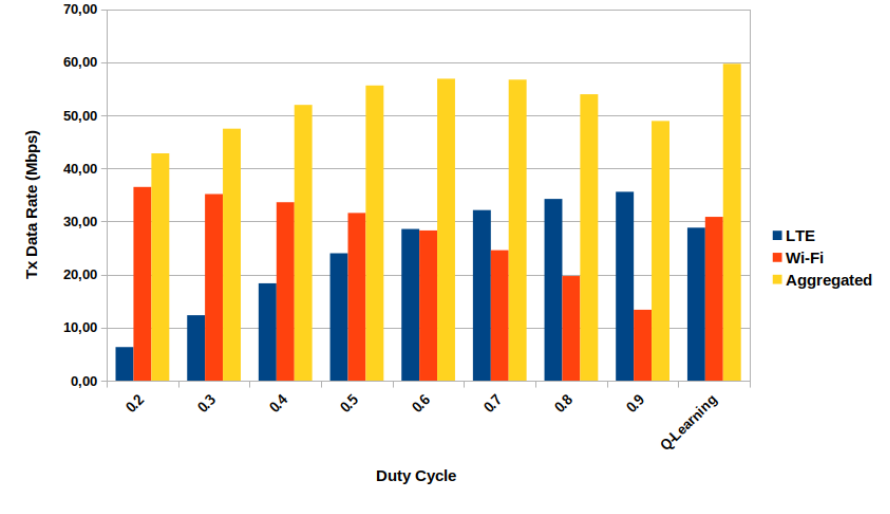
Figure 8. Aggregated transmitted data rate vs DC value including the proposed framework.